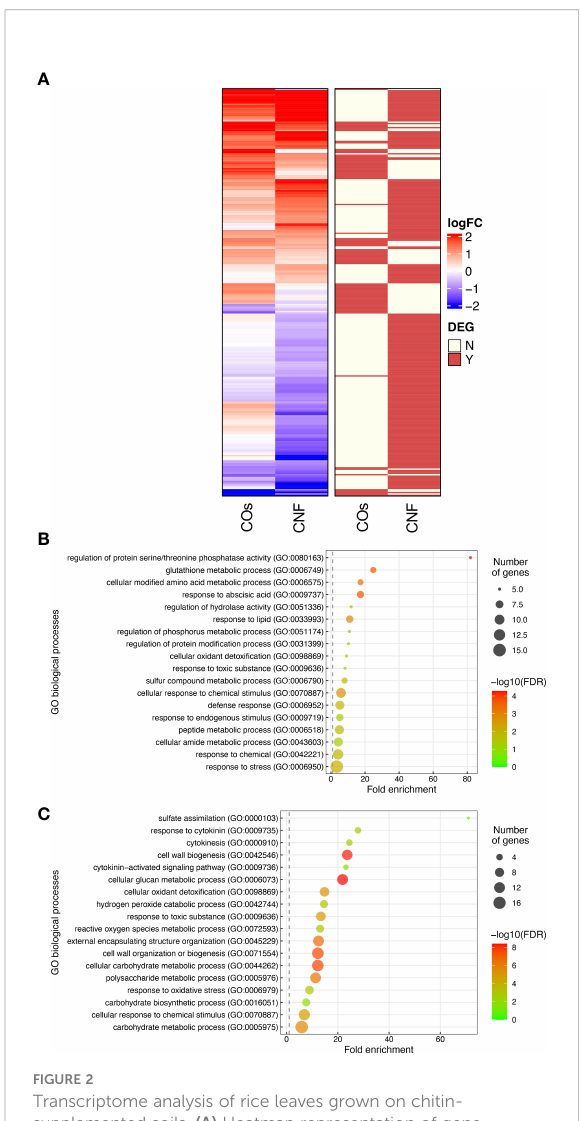
FIGURE 2 Transcriptome analysis of rice leaves grown on chitin- supplemented soils. (A) Heatmap representation of gene expression levels of differentially expressed genes (DEGs) in response to COs and CNF (left). LogFC is shown between − 2 and 2, with outside values indicated as 2 or − 2. Red, upregulated genes; blue, downregulated genes. DEGs in each treatment are indicated on the right. Red, DEG; ivory, not differentially expressed. (B, C) Results of Gene Ontology (GO) enrichment analysis summarised as plot data for upregulated DEGs in chitin- treated samples (B) and downregulated DEGs (C)